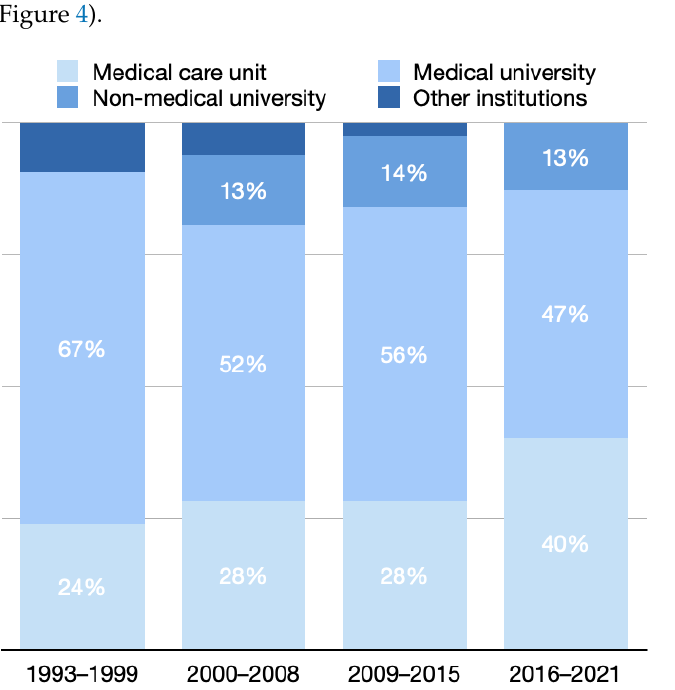
Figure 4. Distribution of studies in various practice settings in different periods.